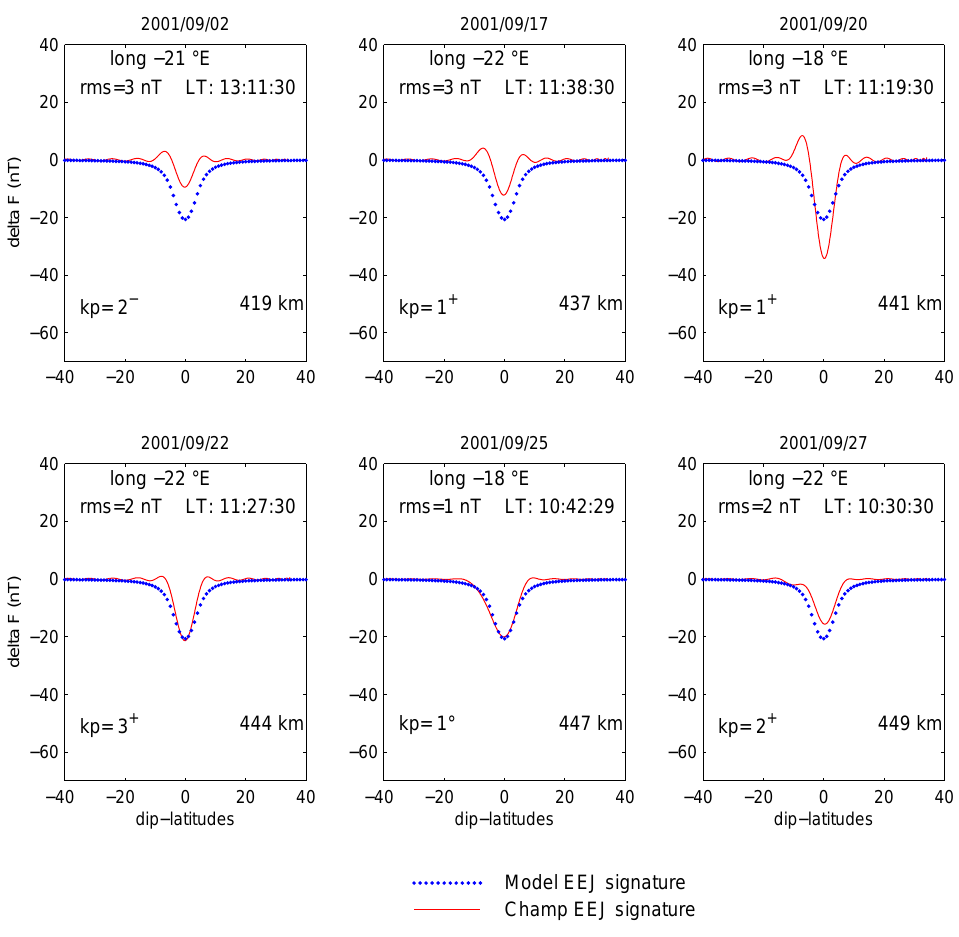
Fig. 7a. Comparison between the CHAMP satellite magnetic signature and the modeled magnetic effects of the EEJ. The modeled EEJ magnetic effects extrapolated at the altitude, longitude and local time of CHAMP satellite passes (blue dotted line) are compared with the observed EEJ signatures (red solid line) in the longitude band 15 ◦ W to 30 ◦ W. The modeled profiles were computed using the mean longitudinal profile of the EEJ magnetic signature. The altitude, longitude, local time and the rms are